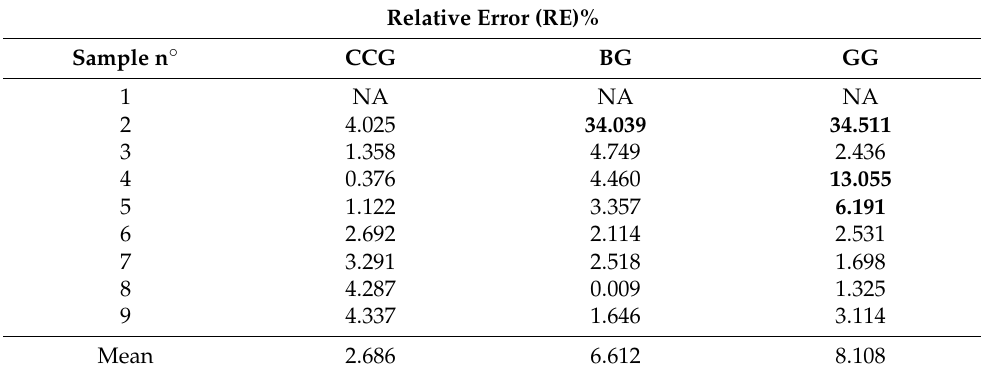
Table 4. Summary of accuracy for added water quantification in test samples